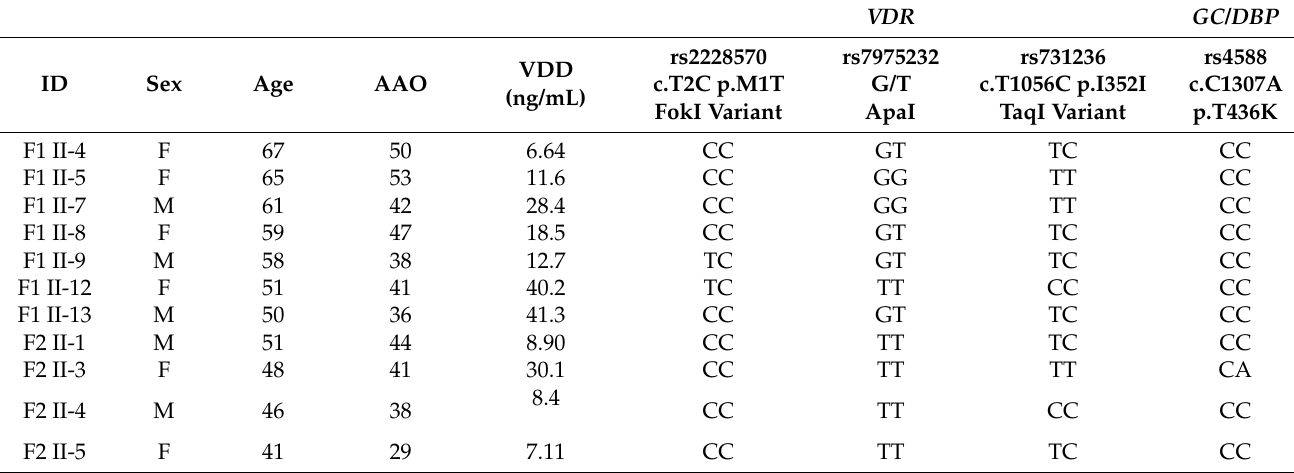
Table 6. Genotype distribution of the VDR and GC polymorphisms associated to vitamin D levels.